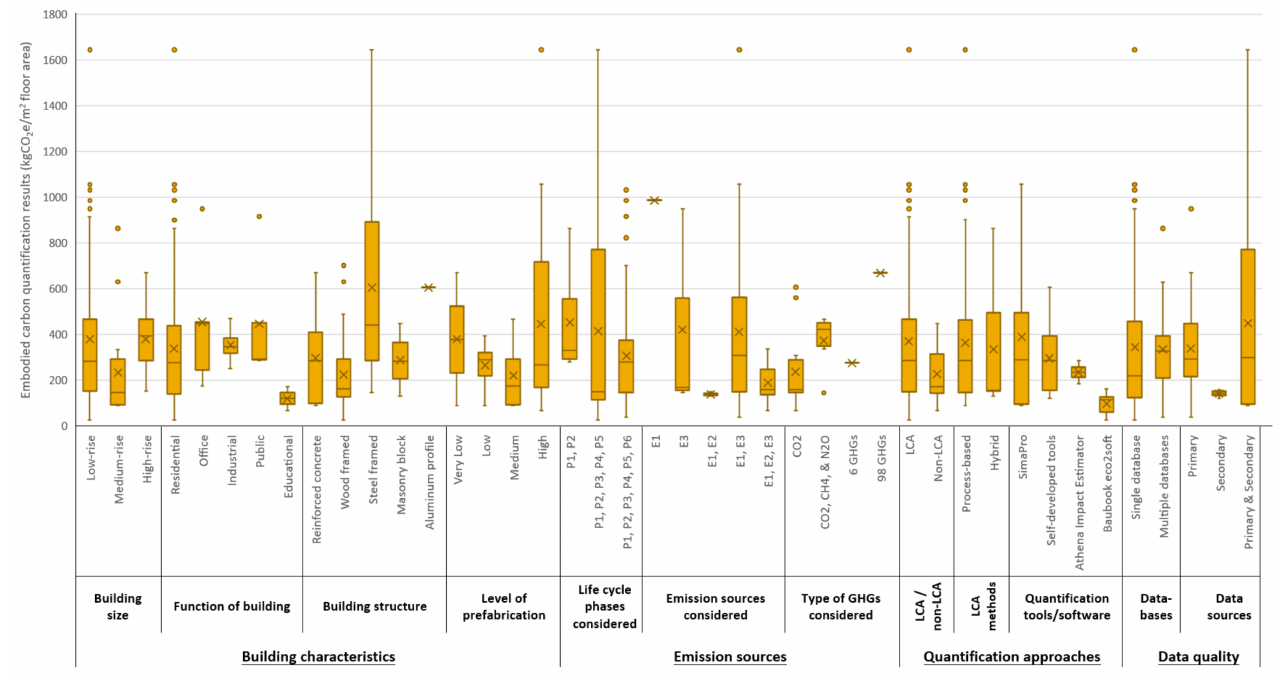
Figure 5. Box plots for embodied carbon emission of building cases against the twelve influencing